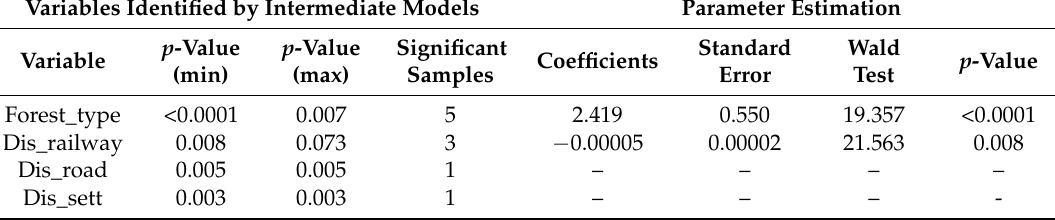
Table 4. Variables identified by intermediate models using logistic regression and parameter estimation using the selected variable.